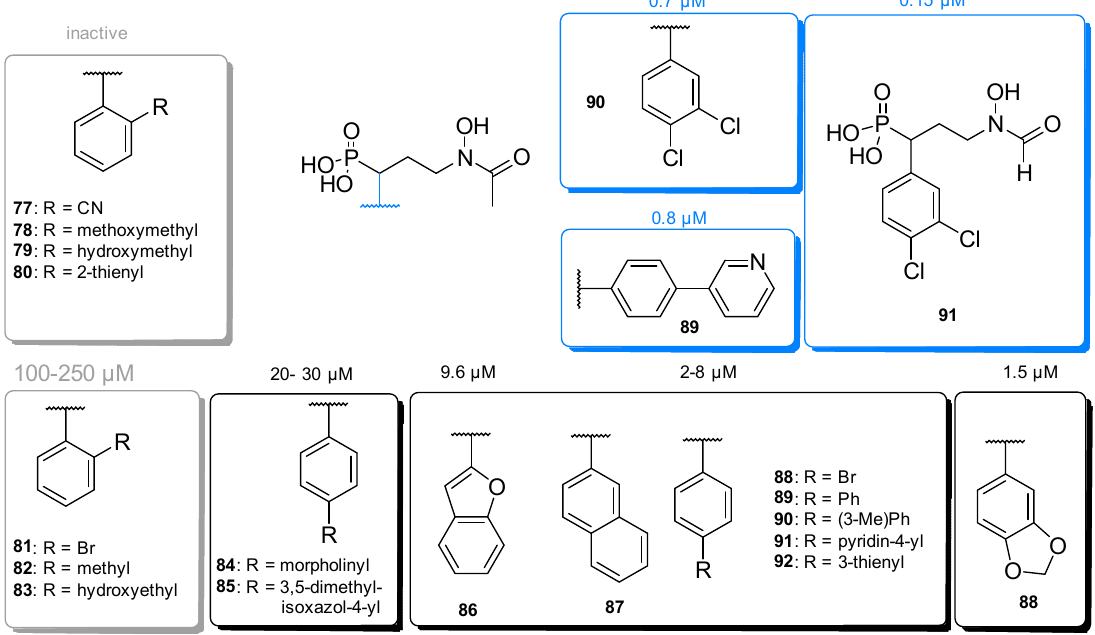
Figure 18. Structure–activity relationship of α -substituted FR900098 analogs 77 – 90 , the N -formyl analog 91 and their activity against Mt DXR.